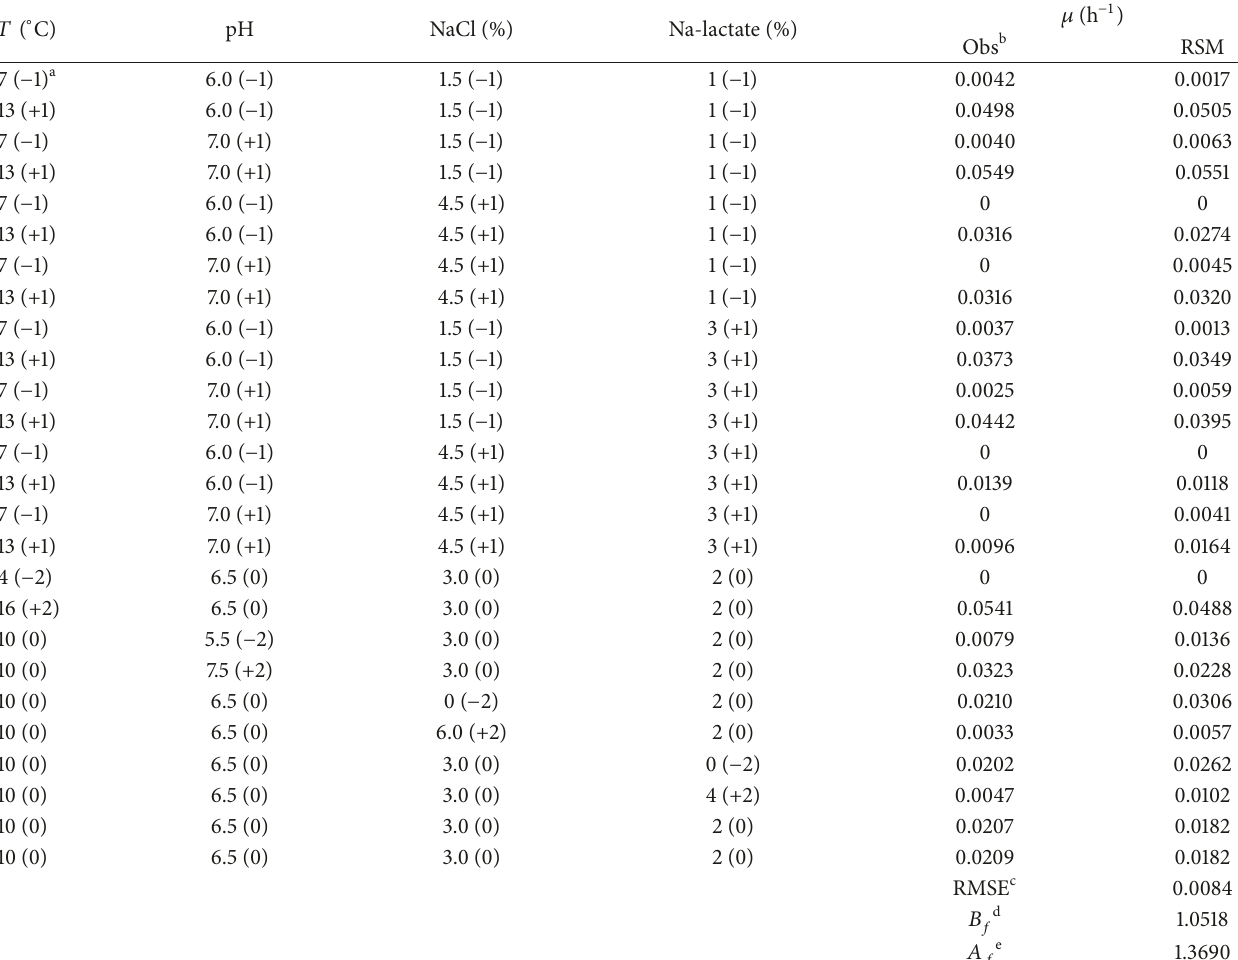
Table 1: Observed (Obs) and predicted growth rate ( 𝜇 , h −1 ) by response surface model (RSM) of L. plantarum for the central composite rotatable